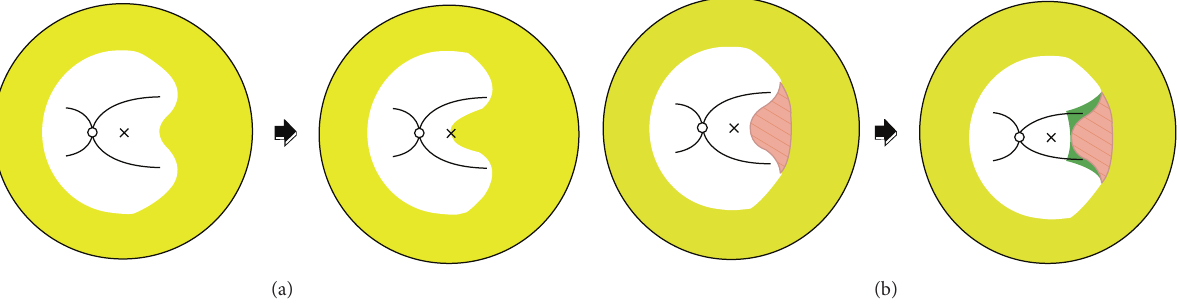
Figure 1: Diagrammatic presentation of the dilemma in the treatment of APROP. (a) Confluent laser ablation (yellow) without skipped areas; the expansion of the scar may induce the cecocentral scotoma. (b) Posterior pole sparing laser to avoid the scotoma; the spared area (red slash) can induce the fibrovascular membrane (green), as well as macular traction and distortion. APROP: aggressive posterior retinopathy of prematurity.